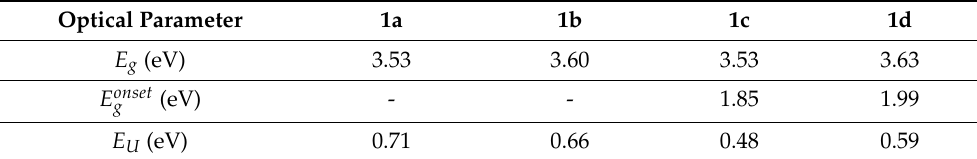
Table 5. Energy gap and Urbach energy. Optical